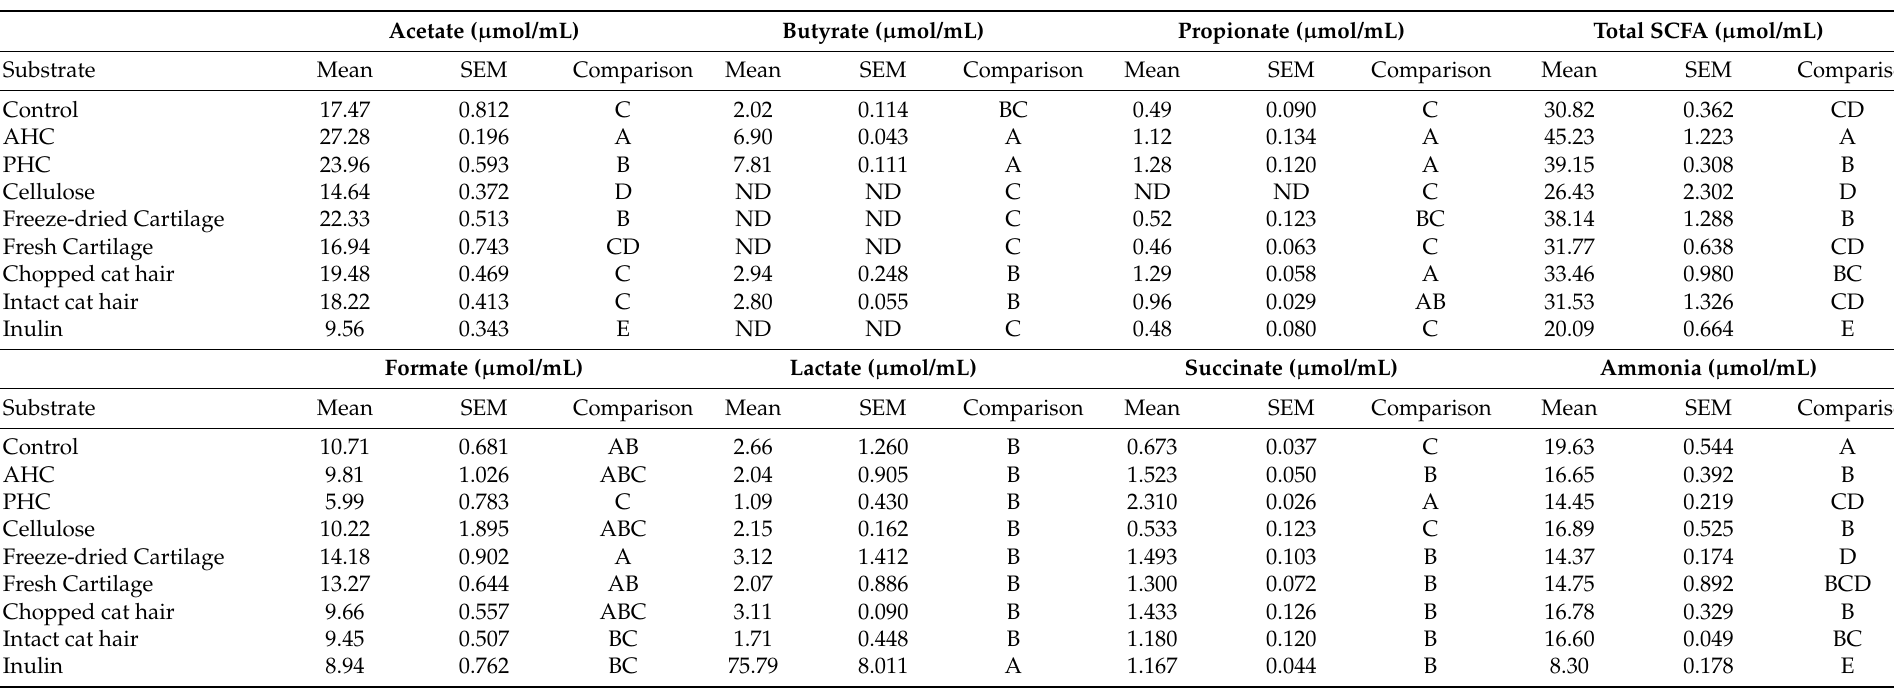
Table 2. Predicted means and associated standard error of the mean of organic acids and ammonia concentrations following in vitro fermentation of each substrate at the 24-h time point in the PD (high protein) faecal inoculum. Letter-based representation of pairwise comparisons is presented. Different letters indicate differences at significance level 0.05, adjusted using the Tukey method. AHC; ANZCO hydrolysed collagen. PHC; Peptan hydrolysed